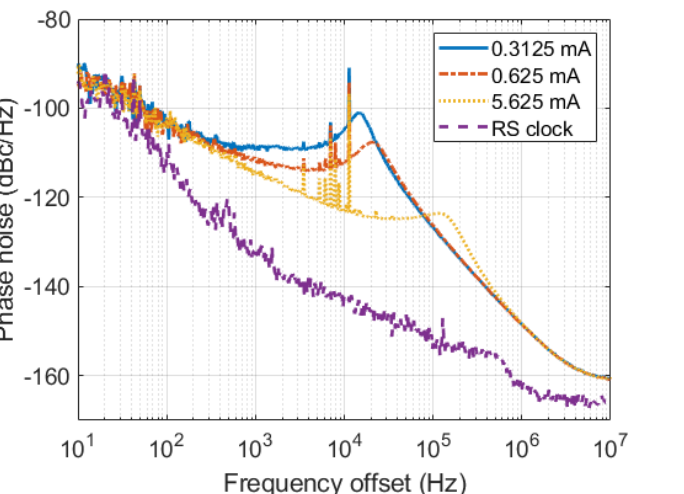
Figure 9. Characterization of the phase noise for an 800 MHz clock signal synthesized using LMX2582 PLL with different charge pump currents. The reference clock source by the Rohde and Schwarz SMA100B is also plotted for comparison